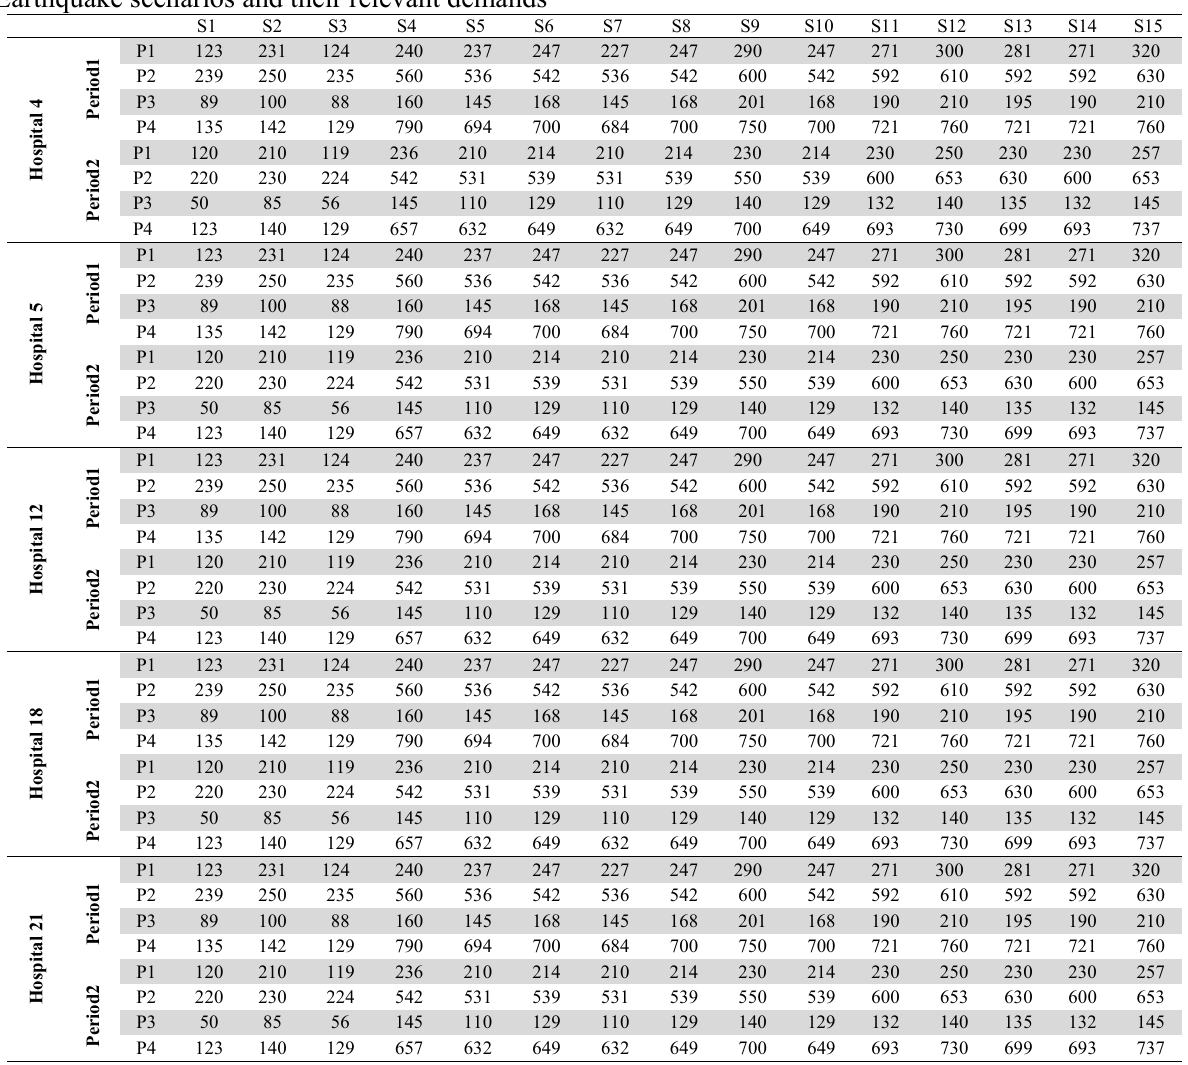
Earthquake scenarios and their relevant demands